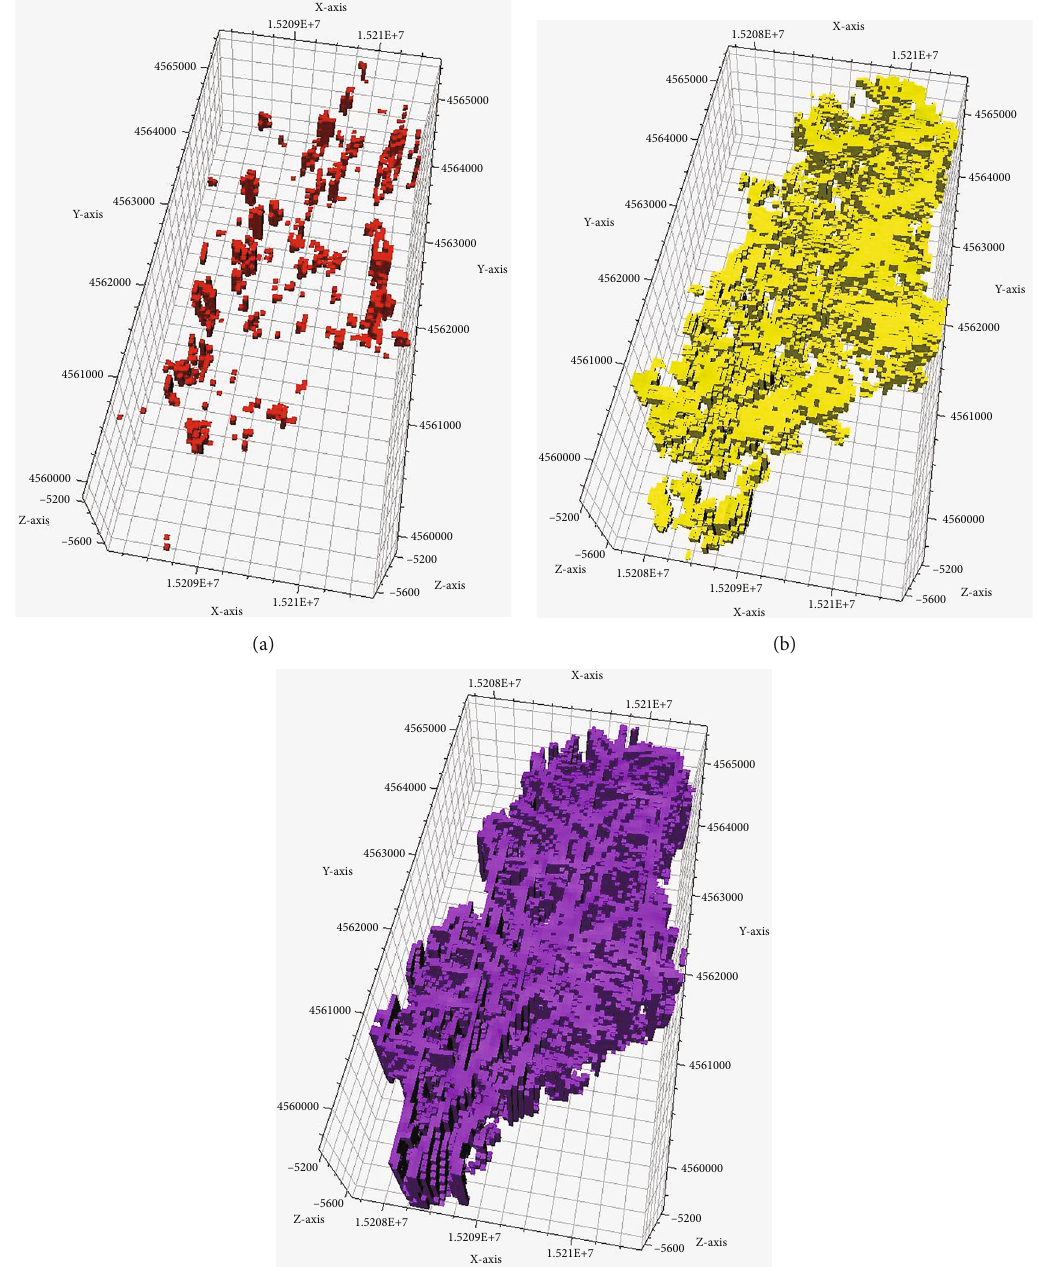
Figure 1: Distribution characteristics of L11 unit